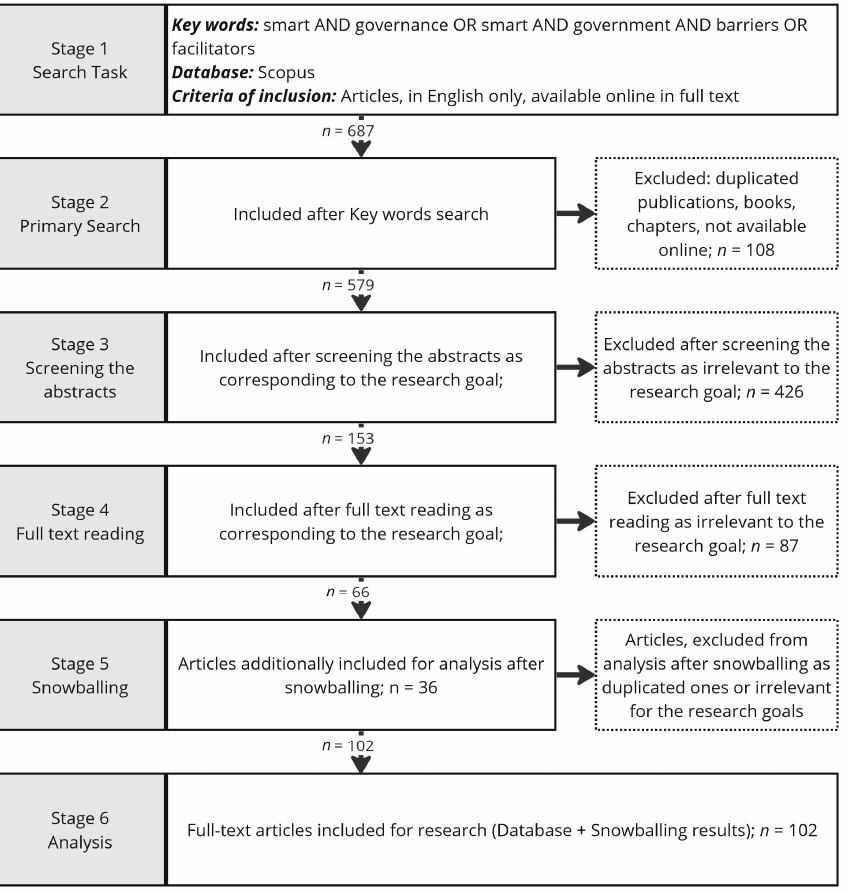
Figure 1. Procedure of selecting articles on barriers and facilitators for qualitative analysis. Source: generated by the authors.